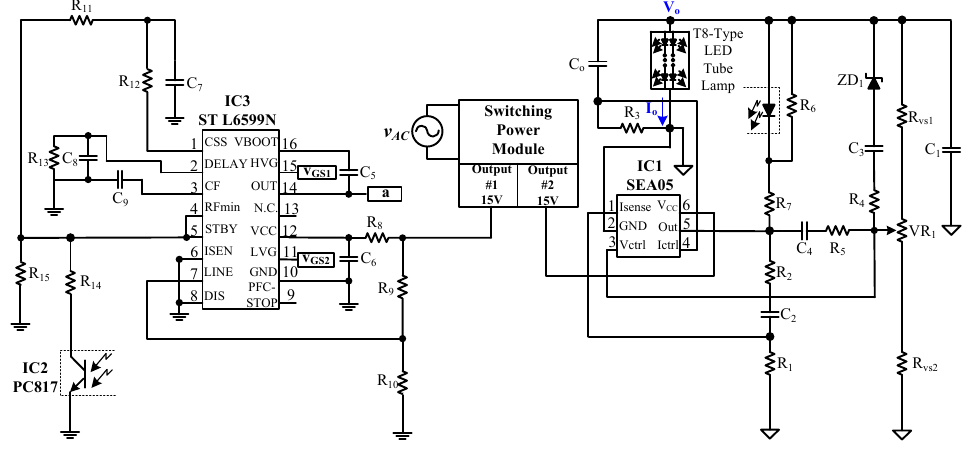
Figure 5. The utilized control circuit for the presented LED tube lamp driver.